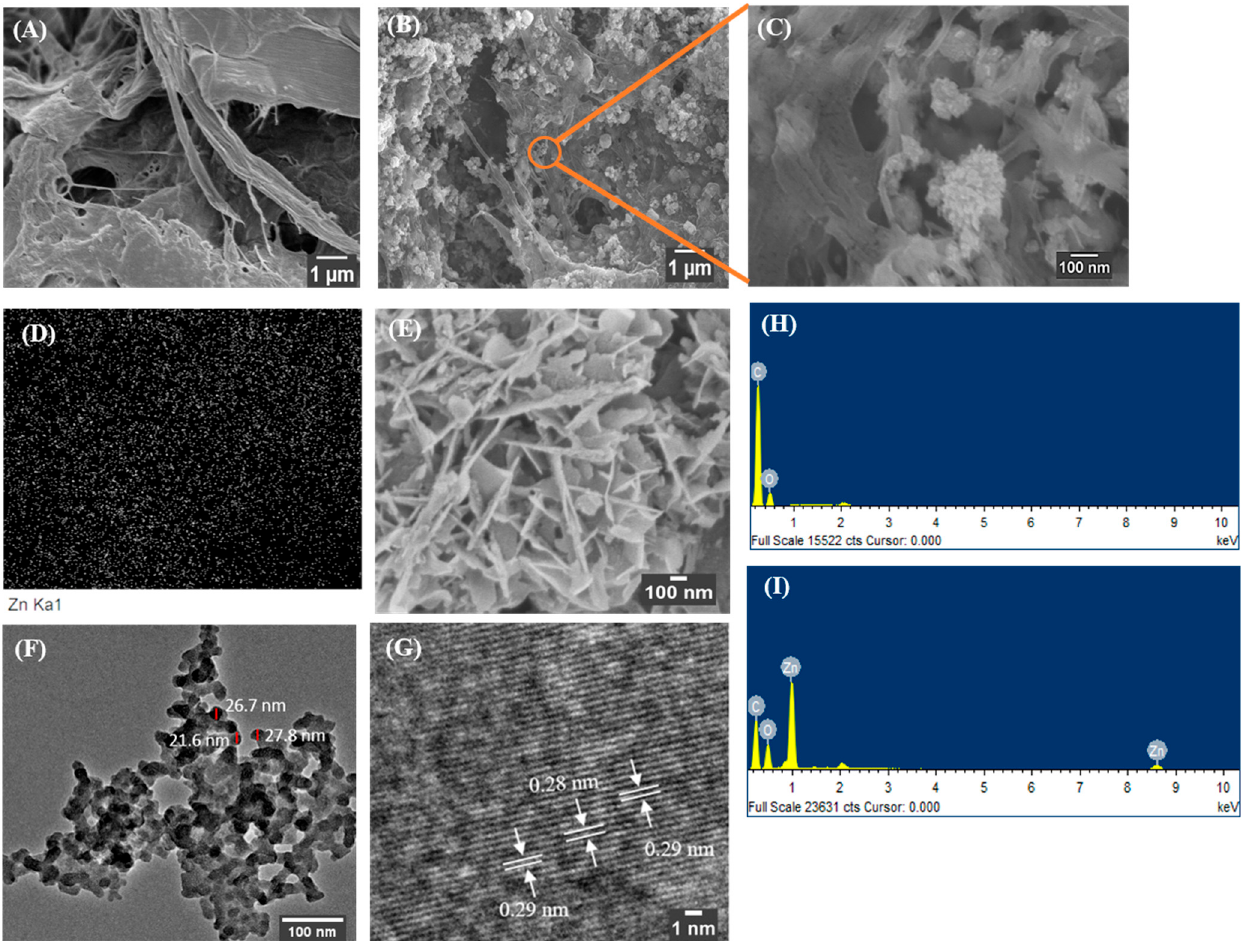
Figure 2. FESEM, EDX, and TEM analysis. ( A ) Pure CNF, ( B ) CNF-ZnO nanocomposite (pH 10), ( C ) Focused image of CNF-ZnO ( D ) EDX mapping of CNF-ZnO (pH 10), ( E ) ZnO NP synthesized at pH 10, ( F ) TEM of ZnO from nanocomposite, ( G ) Lattice spacing of ZnO, ( H ) EDX Spectrum of pure CNF, and ( I ) EDX Spectrum of CNF-ZnO nanocomposite (pH 10).